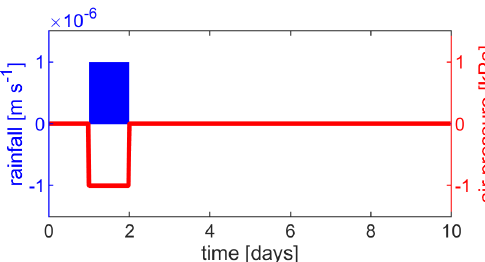
Figure 2. Rainfall recharge and atmospheric pressure variations used for the synthetic tests. The 24h event corresponds to a cumu- lated rainfall of 86.4mm, during which the atmospheric pressure drops